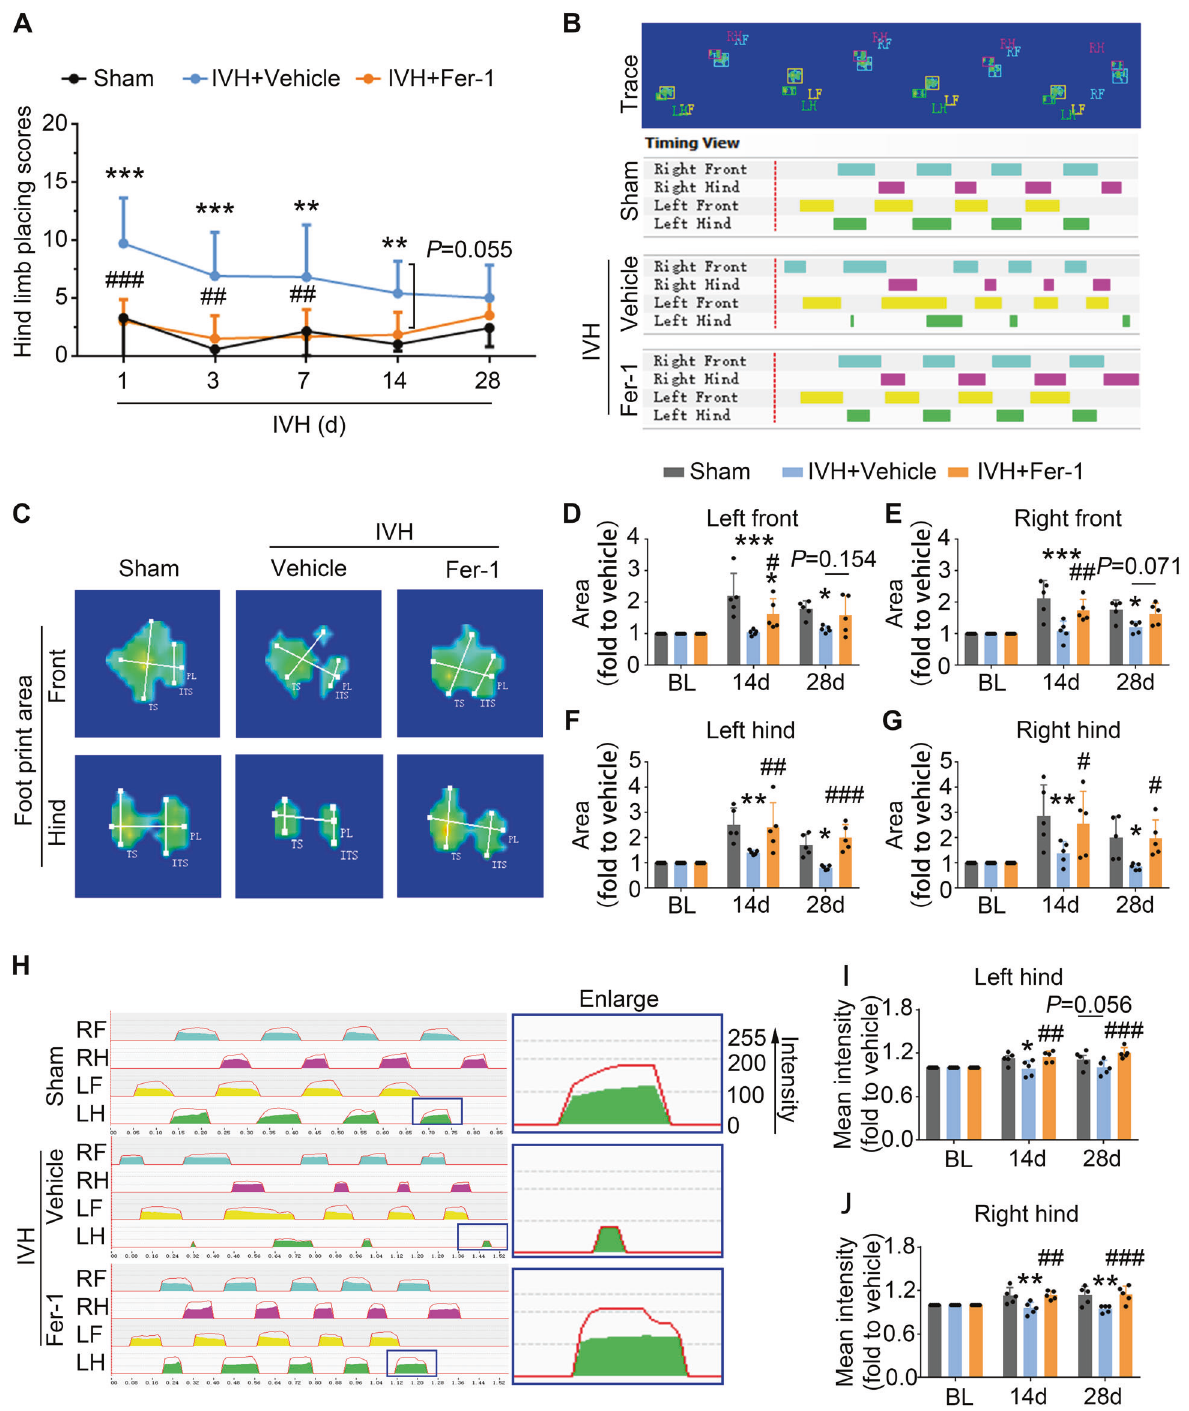
Fig. 6 Administration of Fer-1 improves long-term neurological functions after IVH in vivo. Mice received injection of Fer-1 (i.p.) or vehicle 2 h after IVH and at daily intervals on days 1 – 7 d after surgery. A Hindlimb placement test was assessed at indicated time points. B – J The gait of mice was tested using the CatWalk XT system at indicated time points. B Representative footprints (upper panel) and print pattern (lower panel) are shown. Representative images ( C ) and quanti fi cations ( D – G ) of the footprint area of four paws are shown. Representative images ( H ) and quanti fi cations ( I , J ) of the mean intensity of hind limbs are shown. RF right front paw, LF left front paw, RH right hind paw, LH left hind paw. Results are presented as line graphs or scatter plots (mean ± SD). A , D – G , I , J Two-way ANOVA with Tukey ’ s multiple-comparison test. * p < 0.05, ** p < 0.01, *** p < 0.001 vs. corresponding sham, # p < 0.05, ## p < 0.01, ### p < 0.001 vs. corresponding IVH + vehicle. Each group contained six – nine ( A ), fi ve ( D – G , I , J ) animals. Experiments were repeated at least three times independently.